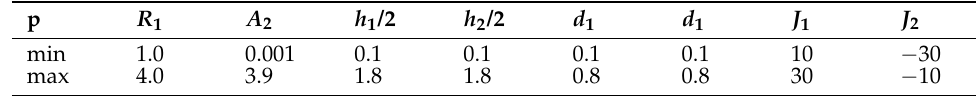
Table 3. Bounds of the design variables for TEAM Problem